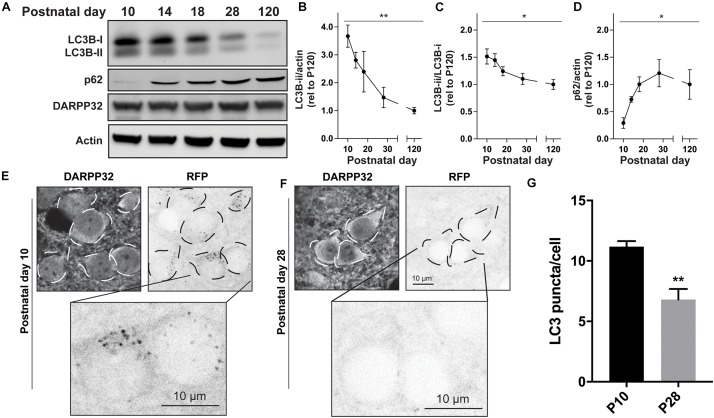
Autophagy decreases during striatal development. (A) Representative Western blot images for LC3B, p62, DARPP32, and actin. Quantification of (B) LC3B-ii relative to actin, (C) LC3B-ii relative to LC3B-i, (D) p62 relative to actin normalized to P120 values. Data analyzed with one-way ANOVA; (B) Age: F(4,21) = 6.526, p = 0.0014; (C) Age: F(4,22) = 3.797, p = 0.0171; (D) Age: F(4,15) = 3.762, p = 0.0260. *p < 0.05, **p < 0.01, n = 4–6 mice/age. (E,F) Representative images of DARPP32 stained striatal neurons and RFP fluorescence from mice aged P10 and P28. Dashed lines indicate cell body outlines. (G) Quantification of number of LC3 puncta/cell. Unpaired, two-tailed t-test, t4 = 4.392, p = 0.0118. N = 3 mice/age, 20–50 cells were analyzed per mouse.